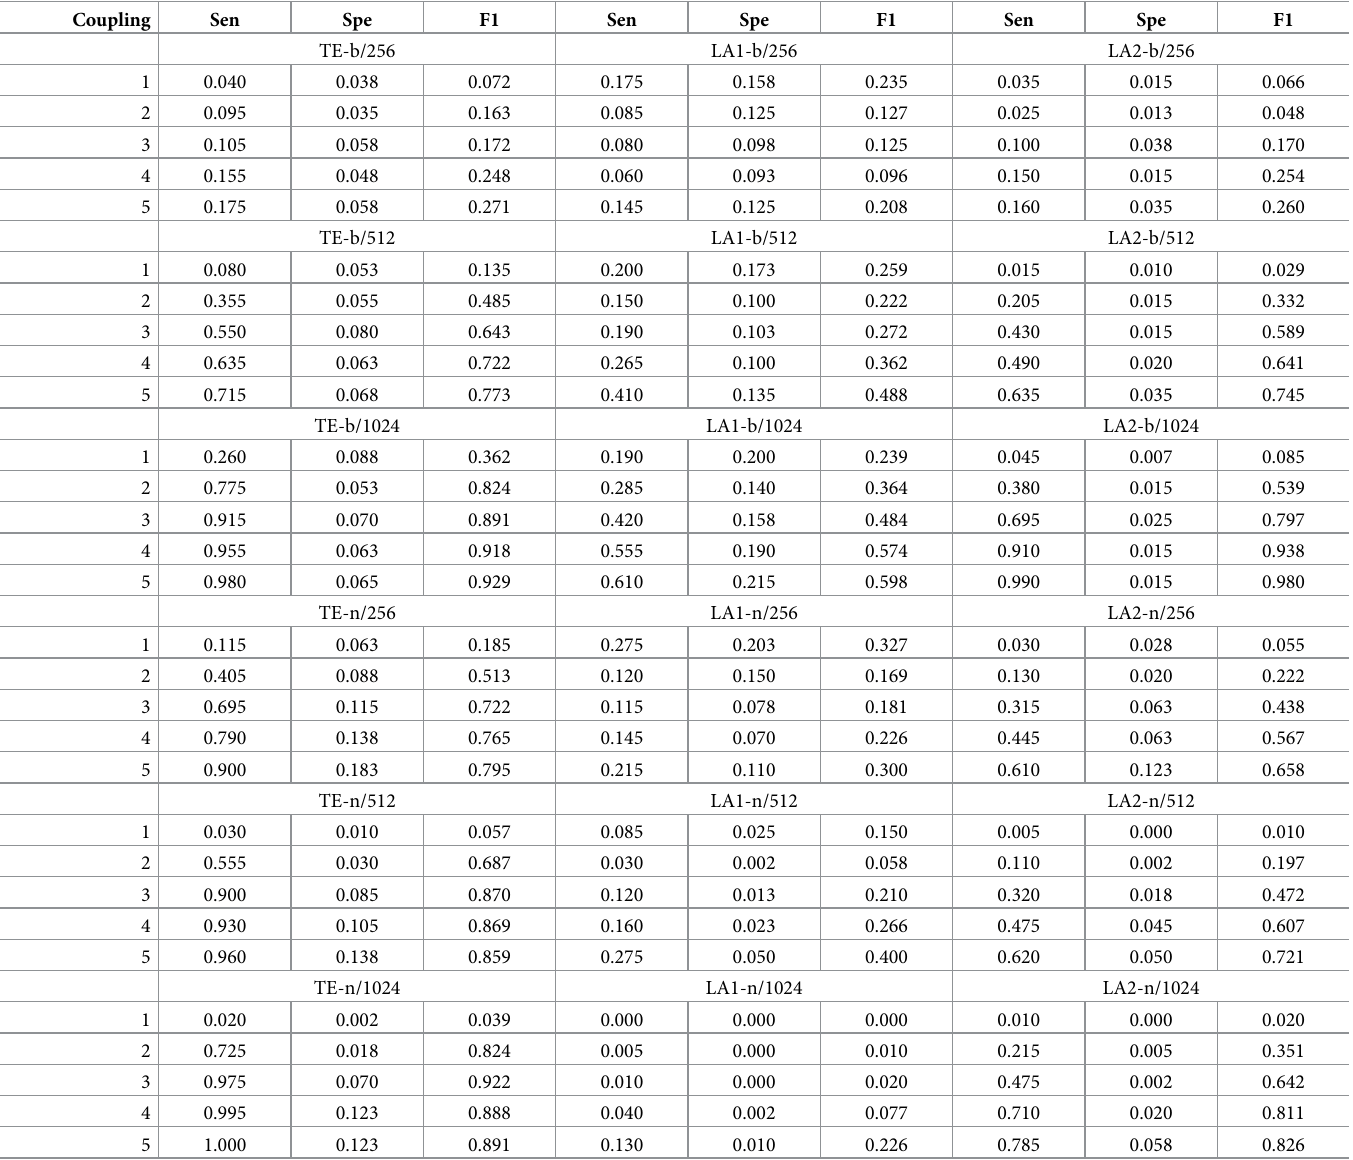
Table 7. Sensitivity, specificity and F1 score values obtained from Model G by binning(-b) and NN(-n) estimators with different data lengths and coupling